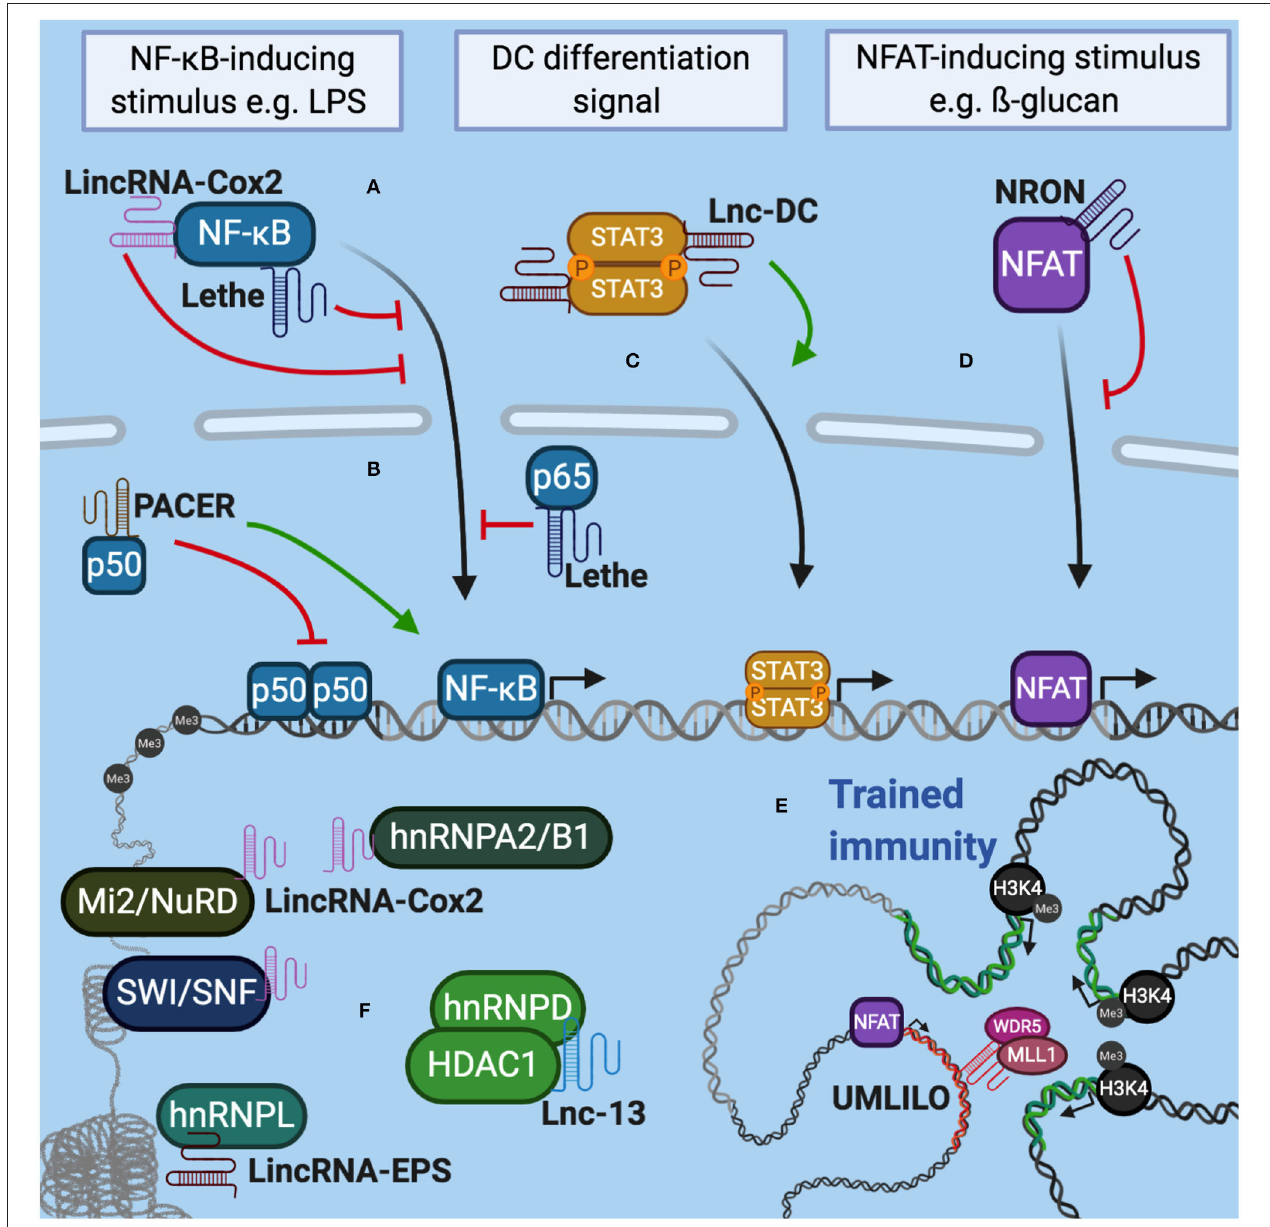
FIGURE 1 | LncRNAs interact with molecular complexes that regulate the expression of genes associated with the immune response. (A) Lethe and LincRNA-Cox2 can interact with NF- κ B in the cytoplasm and control its translocation to the nucleus. (B) In the nucleus, Lethe modulates inflammation by sequestering p65 from NF- κ B. PACER interacts with p50 decreasing the formation of homodimers and favoring the heterodimerization of NF- κ B. (C) In dendritic cells, lnc-DC prevents STAT3 dephosphorylation, promoting its translocation to the nucleus and the expression of genes related to cell differentiation and activation status. (D) In lymphocytes NRON interacts with NFAT to prevent its transit to the nucleus, decreasing the expression of IL-2. (E) The co-regulation of the expression of distant immune genes grouped in the same TAD is mediated by IPL (for example, UMLILO). IPL expression recruits WDR5/MLL histone methyltransferase complex, promoting the epigenetic priming of immune genes contained in TAD. (F) LncRNAs can also interact with hnRNP complexes, chromatin remodeling complexes and histone deacetylases to modulate genome accessibility and control gene expression related to the immune response.